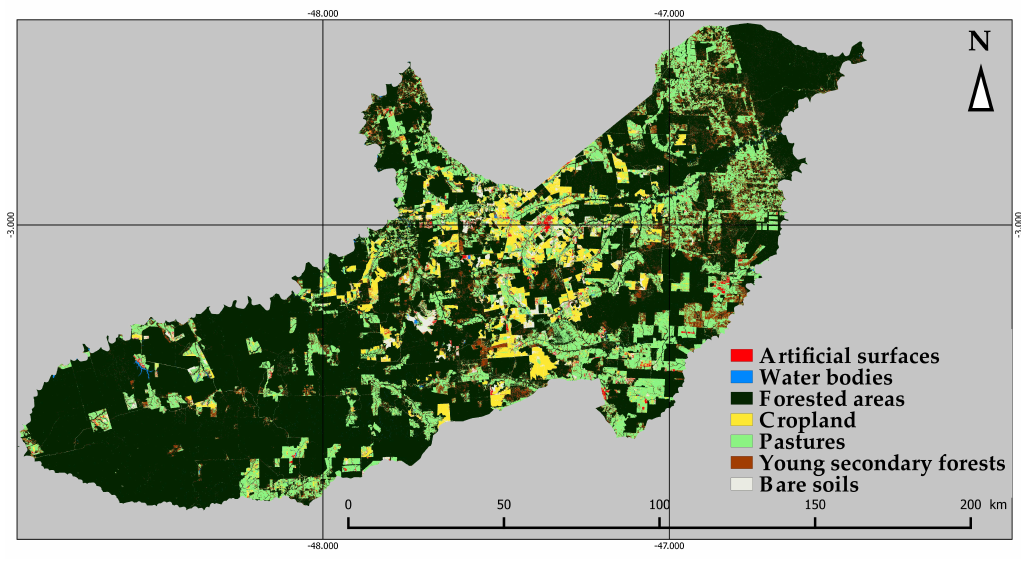
Figure 10. Classification of the Brazilian study area using combined Sentinel-1 and 2 data.